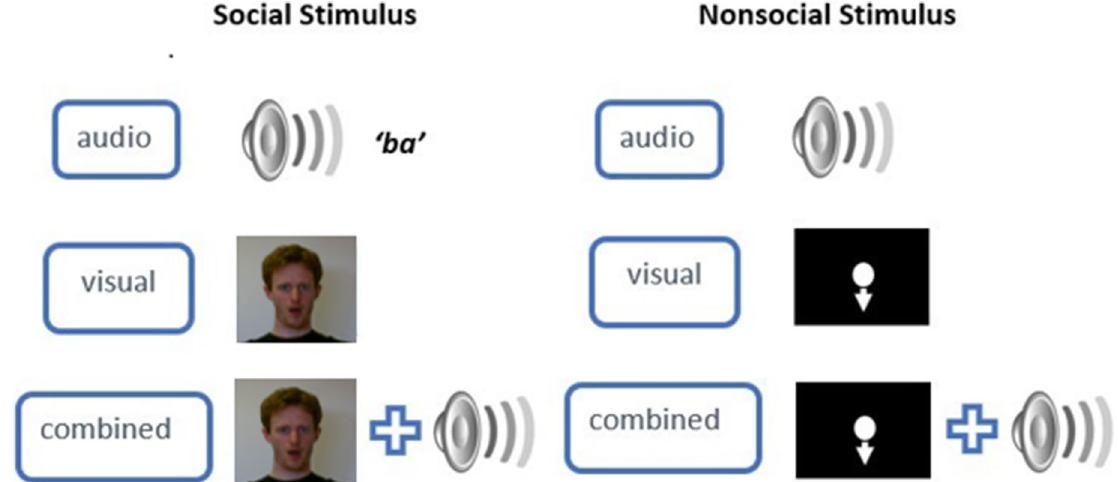
Figure 4. An illustration of the experimental design. Each stimulus type (social or non-social), contained audio only, visual only and audio-visual combined stimuli. For social stimuli, the audio condition consisted of a recording of a rhythmical verbal ‘ ba ’ response (either female or male), the visual condition consisted of a video recording of a female or male person performing the rhythmical ‘ ba ’ response without the presentation of the sound, and the combined condition consisted of a video recording of the female or male person performing the rhythmical ‘ ba ’ response with the sound. For non-social stimuli, either a rhythmical metronome beep (audio), a white vertically moving dot (visual) or both the metronome beep coinciding with the moving dot (combined) were